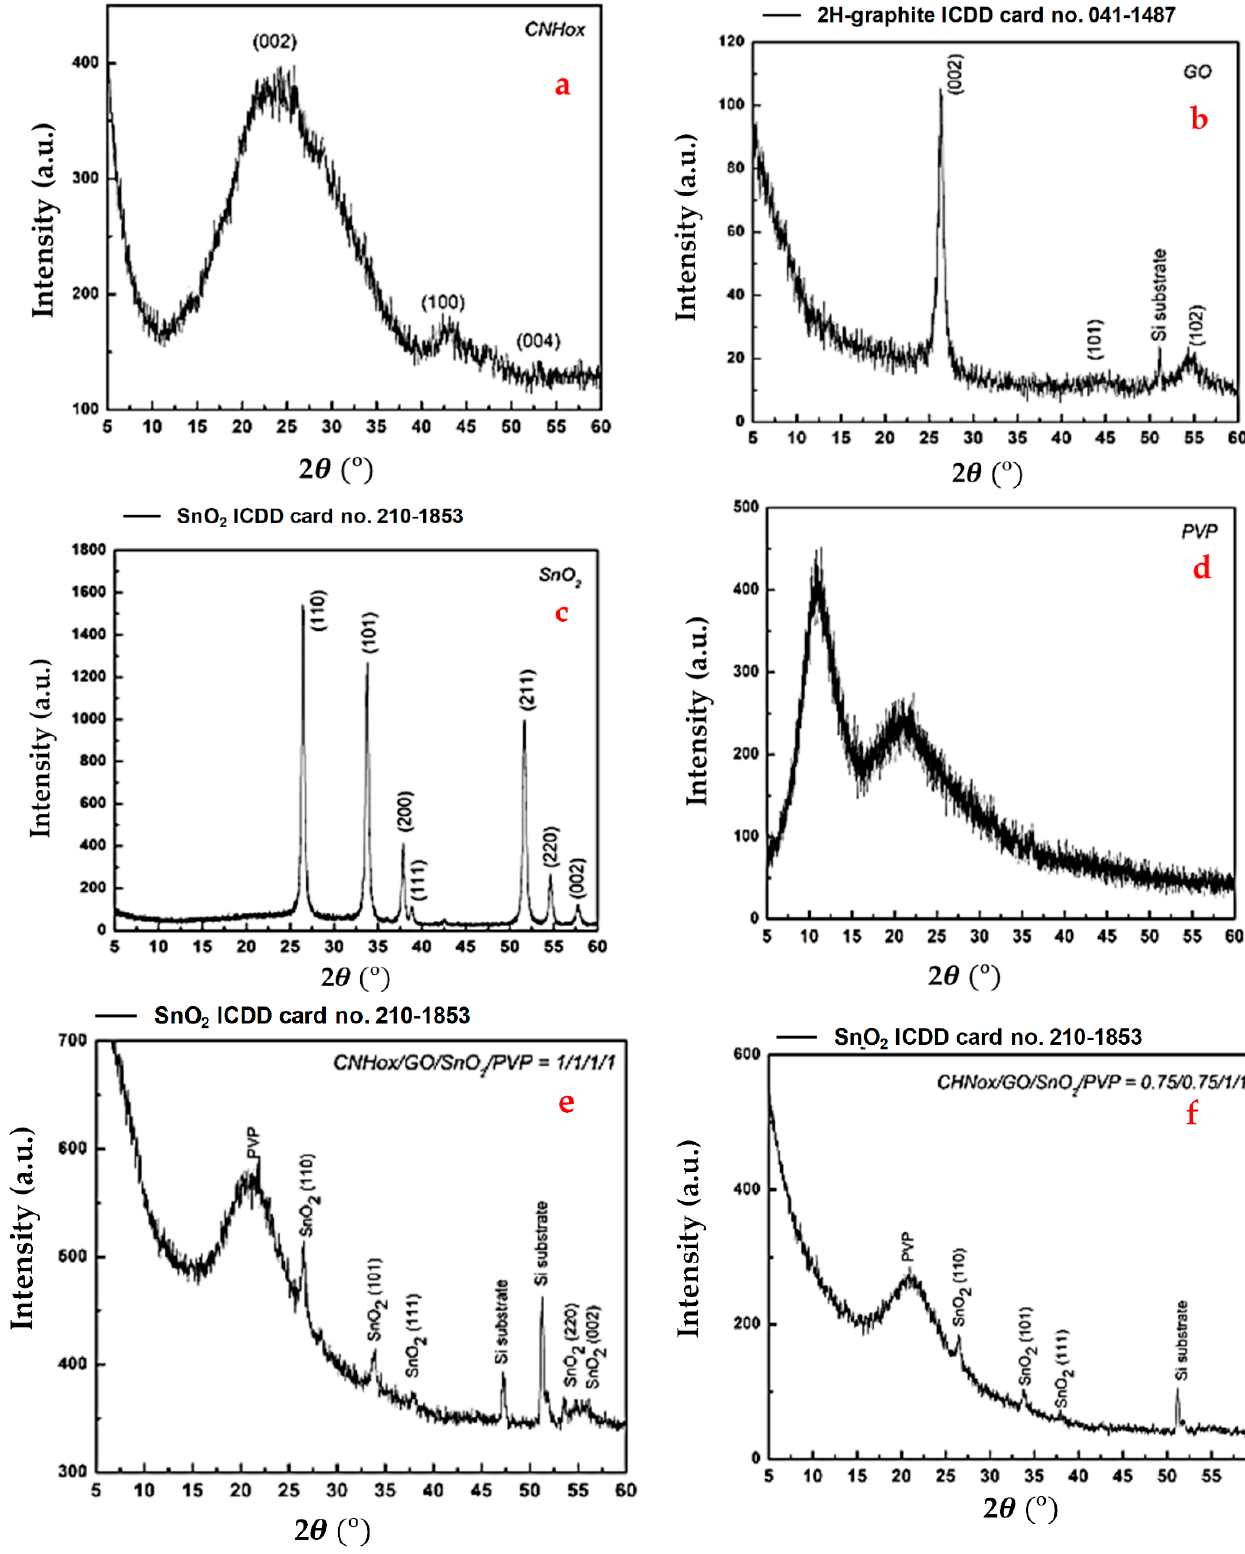
Figure 6. GIXRD pattern for ( a ) CNHox, ( b ) GO, ( c ) SnO 2 , ( d ) PVP, ( e ) CNHox/GO/SnO 2 /PVP = 1/1/1/1 w/w / w/w ratio and ( f ) CNHox/GO/SnO 2 /PVP = 0.75/0.75/1/1 w/w / w/w ratio.